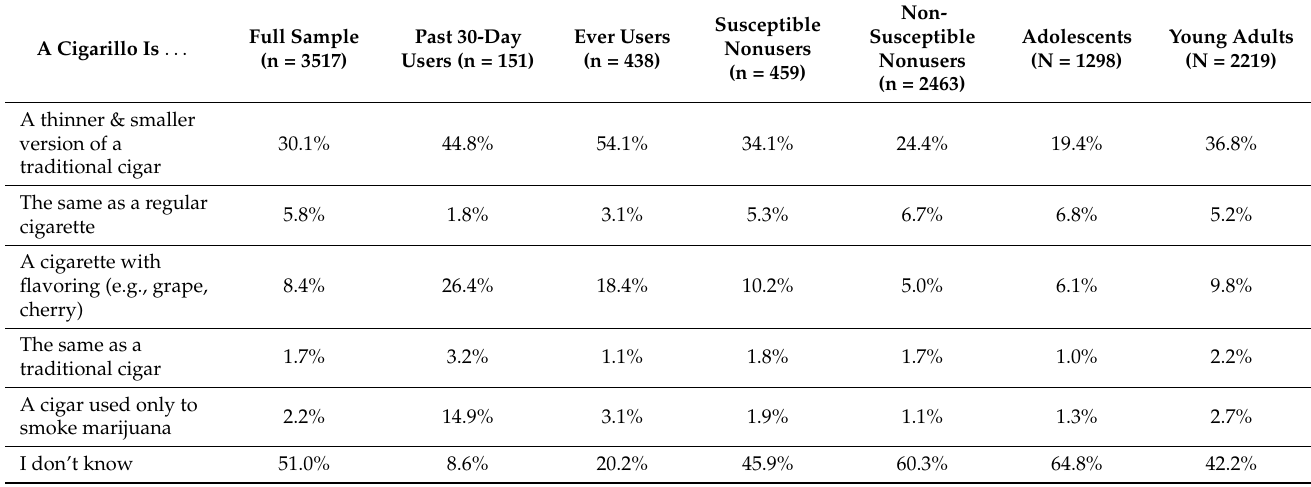
Table 2. Cigarillo definition perceptions by user status and age